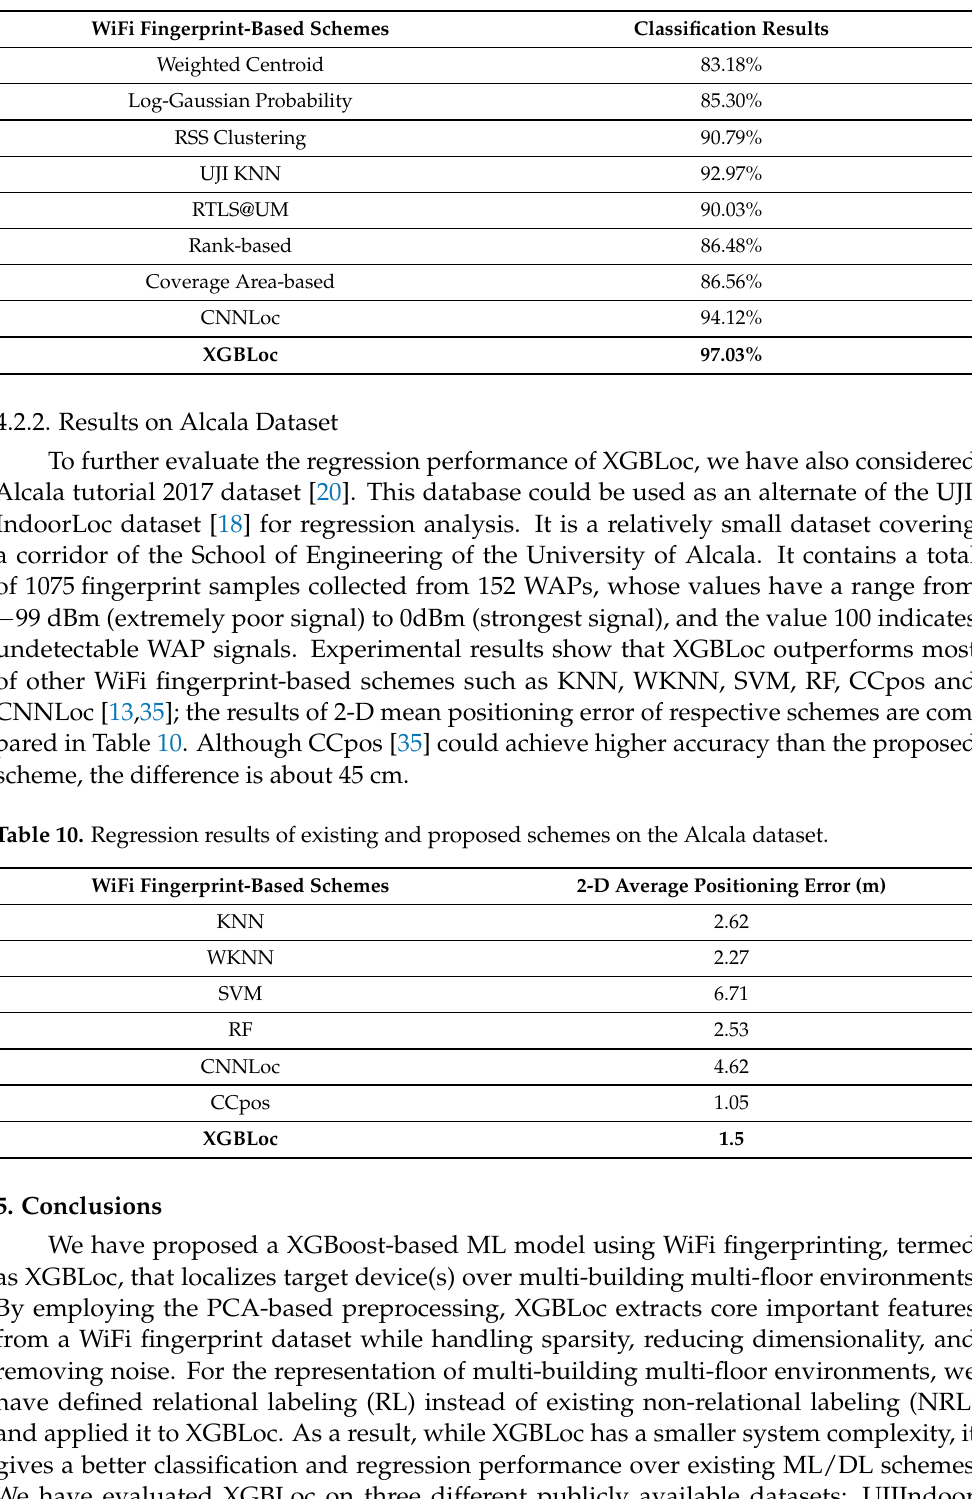
Table 9. Classification results of existing and proposed schemes on the Tampere dataset.